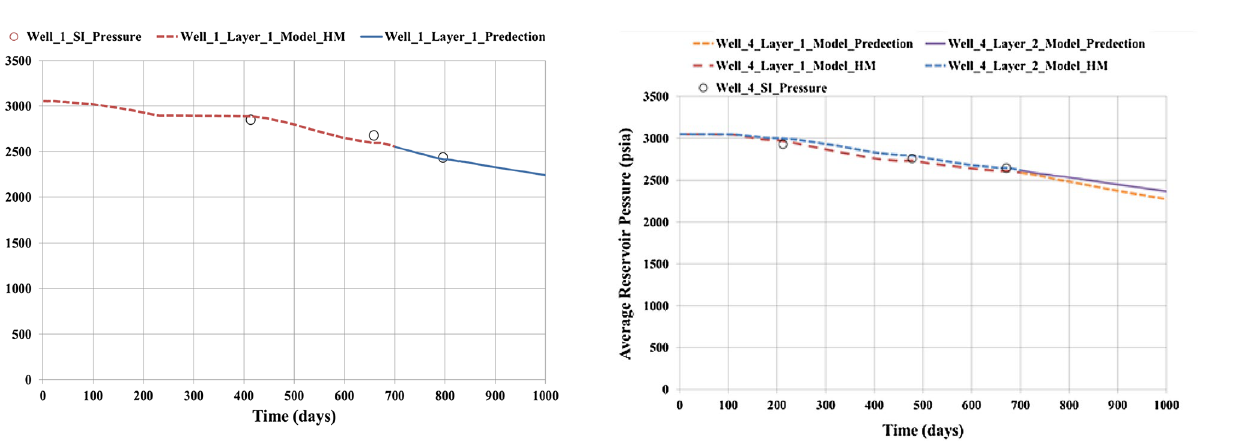
Fig. 9 Well 1 Pressure History Match and Prediction (Case 1)